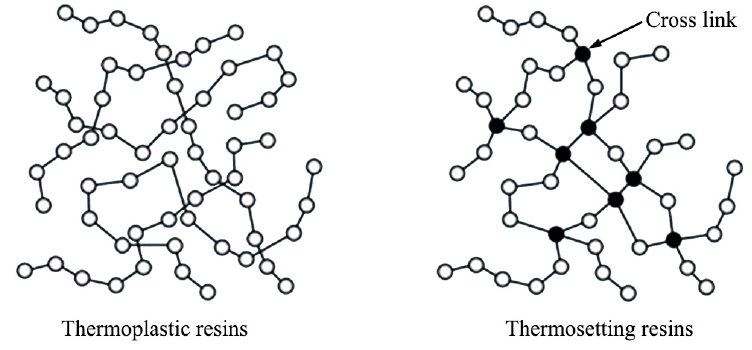
Figure 4. Molecular structures of thermoplastic resins and thermosetting resins.